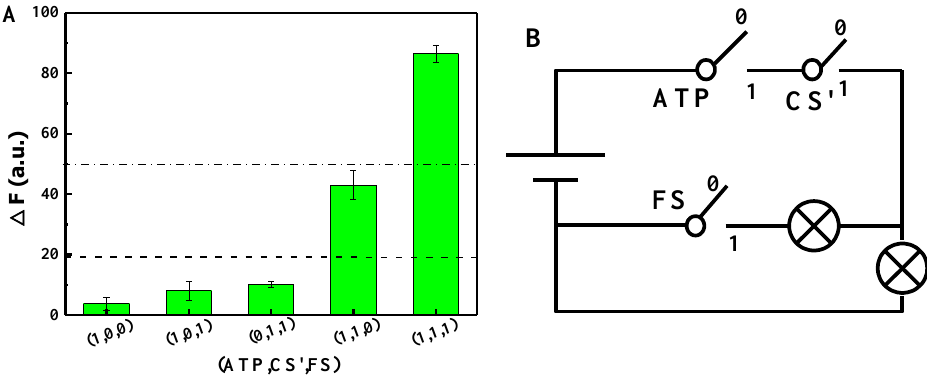
Figure 3. ( A ) Logic histogram and ( B ) the DNA machine Figure 3. ( A )Logic histogram and ( B ) the DNA machine circuit. Figure 3. ( A )Logic histogram and ( B ) the DNA machine circuit.